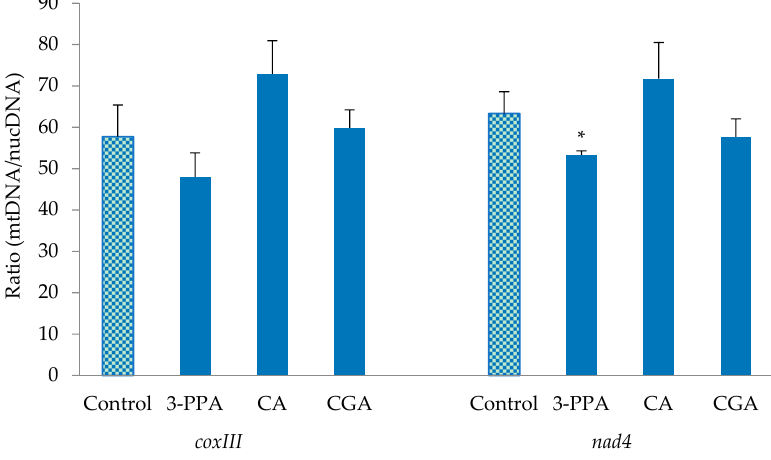
Figure 6. Effect of 24 h treatment with 1000 µ M CGA and its metabolites on Caco-2 cells on the mtDNA content (ratio of mtDNA/nucDNA) as measured by droplet digital polymerase chain reaction (PCR). Data are represented as mean ± SE. CGA = chlorogenic acid; CA = caffeic acid; 3-PPA = 3-phenylpropionic acid. *: significant from the control ( p <